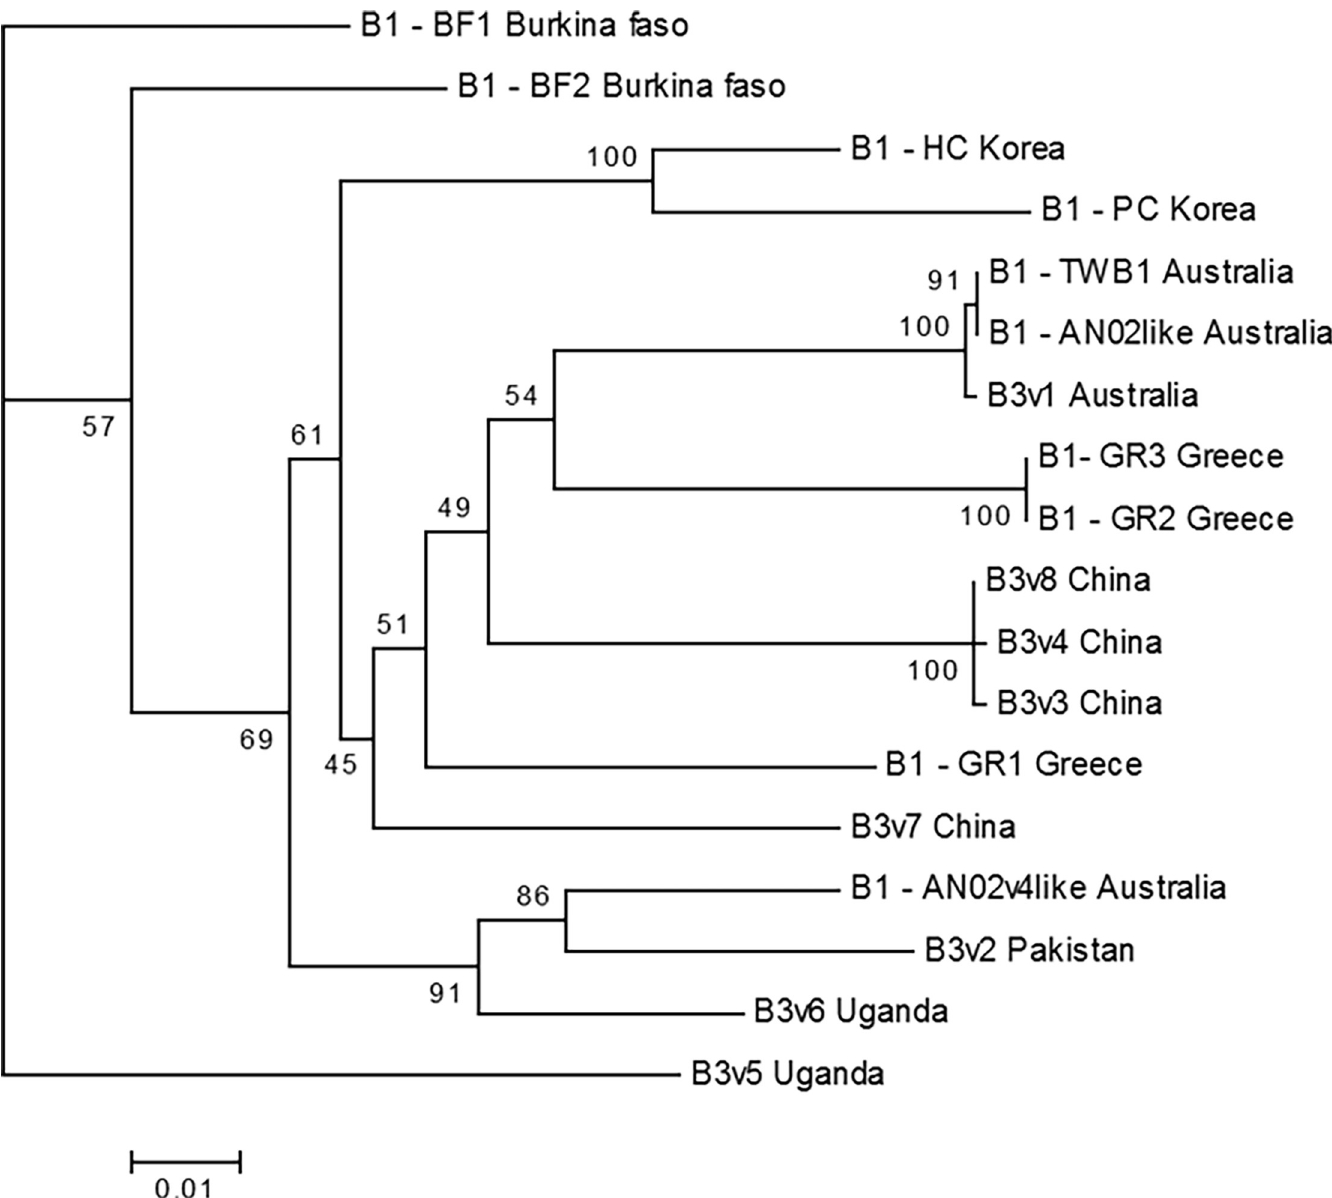
Fig 6. Maximum likelihood phylogeny of CYP337B1 and CYP337B3 alleles. The maximum likelihood tree was generated in IQ-TREE with the HKY+G4 model of sequence evolution, using representative CYP337B1 and CYP337B3 intron sequences. Bootstrap values from 10,000 replicates are given on tree nodes. The eight CYP337B3 alleles are indicated with labels (v1:v8), different CYP337B1 alleles are indicated by B1- followed by an allele ID and the country of origin. Sequences and related NCBI identifiers can be found in S3 Table and S1 File.